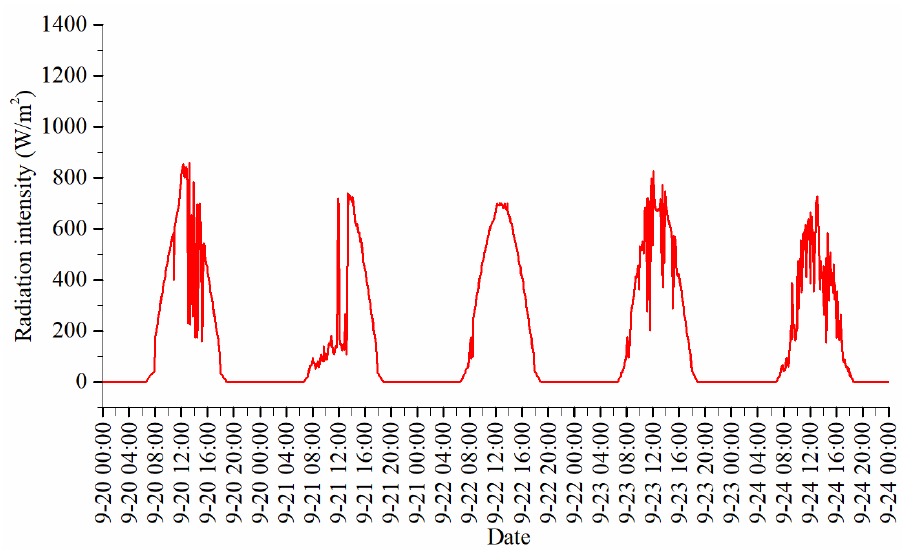
Figure 13. Selection of optimum days for autumn illumination.